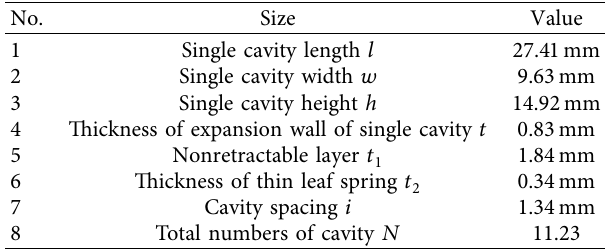
Table 3: Response test results of pneumatic soft-bodied bionic basic execution